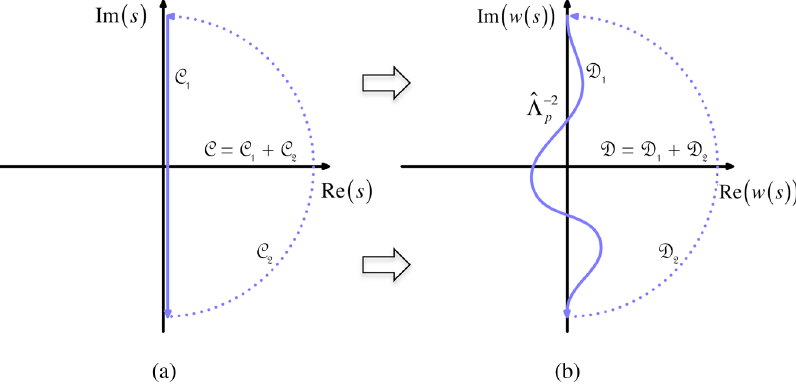
FIG. 1. Mapping from s to w ð s Þ as defined in Eq. (7). The map from C